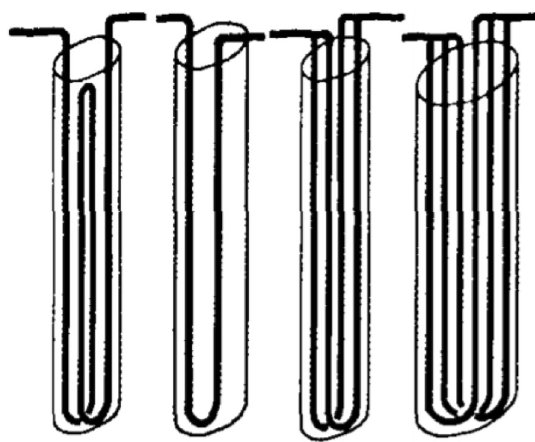
Fig. 19 Different types of heat exchangers [14]. a W-type; b Single U-type; c Parallel double-U-type; d Parallel three-U-type